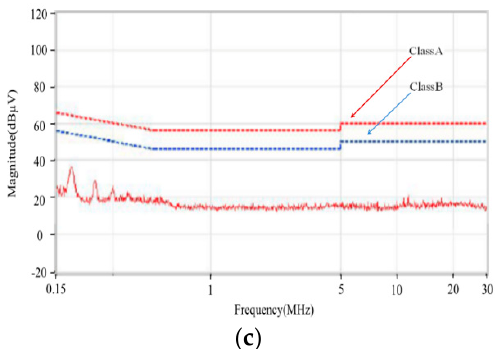
Figure 31. CM interference on DC side after suppression: ( a ) suppressed CM interference by second-order filter; ( b ) suppressed CM interference by spread spectrum technology; ( c ) suppressed CM interference by three-phase four-leg rectifier.